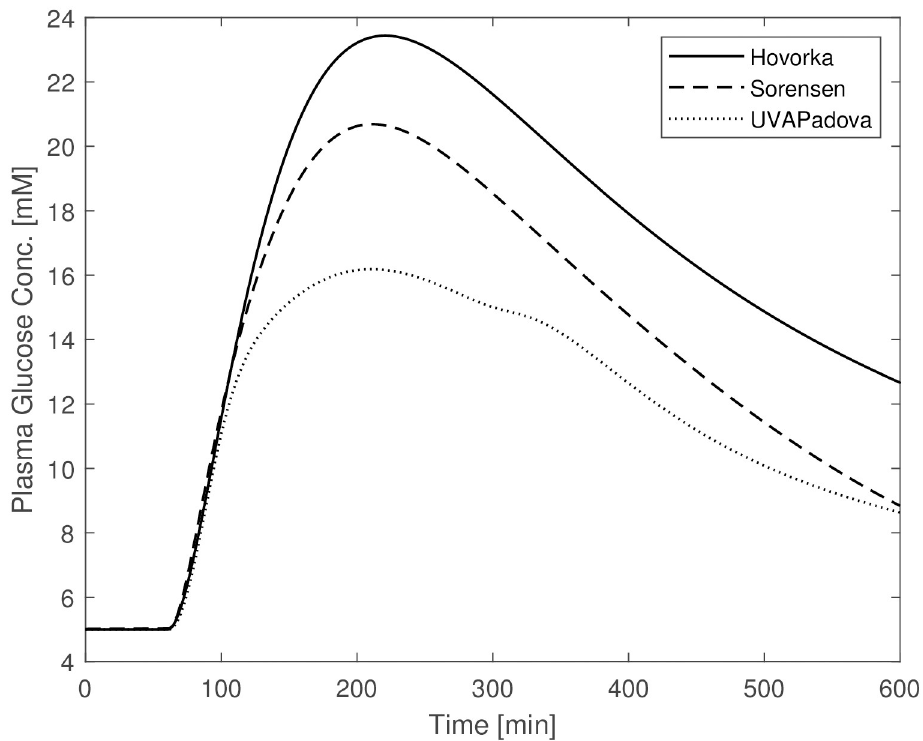
Fig 3. Blood glucose concentrations from the Hovorka (solid line), Sorensen (dashed line) and UVAPadova (dotted line) models, during the in-silico OGTT experiment.